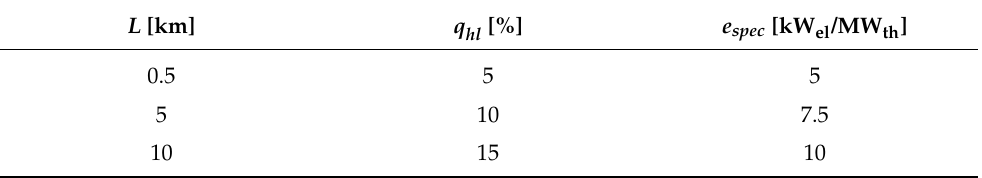
Table 2. Heat losses and specific electricity consumption for different distances to the campus